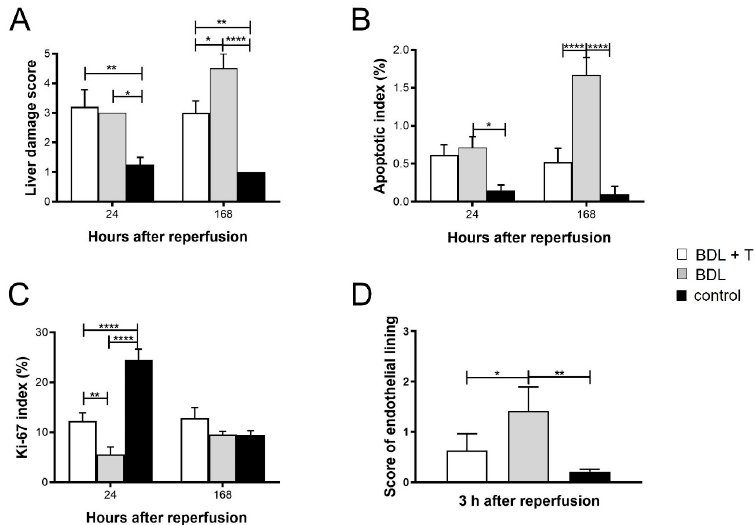
Figure 7. Histopathological changes in livers in the different treatment groups were analyzed in ( A ) Hematoxylin and eosin (HE) staining applying a semi-quantitative score, in ( B ) transferase-mediated d-UTP nick-end labeling (TUNEL) staining shown as apoptotic index (in %), in ( C ) Ki-67 staining measuring proliferation (in %) of Kupffer cells and sinusoidal endothelial cells and infiltration of inflammatory cells and in ( D ) RECA-1 staining in order to score the endothelial lining. Mean and standard deviation are shown in each group with significance levels of * p < 0.05, ** p < 0.01, **** p < 0.0001.